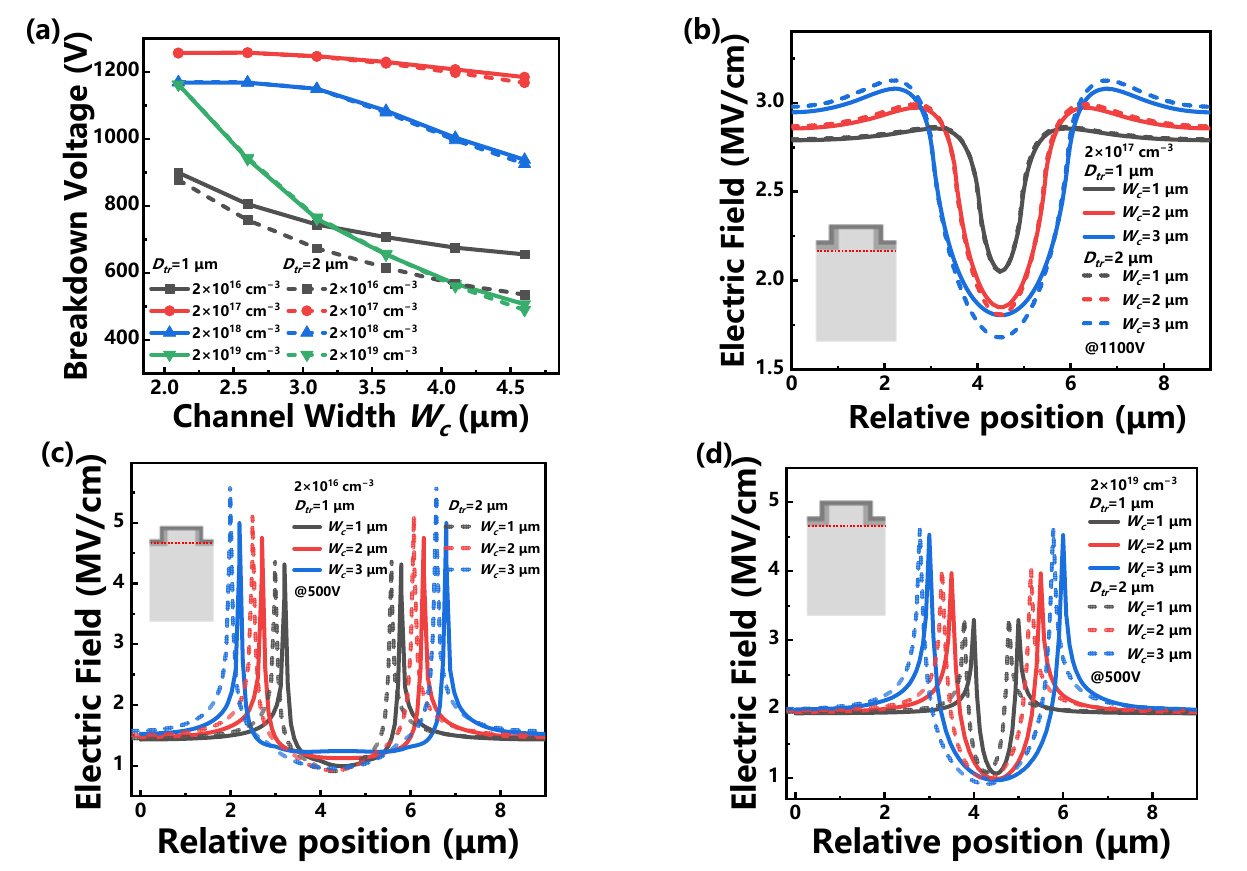
Figure 6. ( a ) Breakdown voltages of TJBS diodes with different p-doping concentrations as a function of adjacent p-GaN spacing and its depth; ( b ) Electric field profiles at the bottom of p-GaN with a doping concentration of 2 × 10 17 cm − 3 and with different D tr and W c of TJBS at a reverse bias voltage of 1100 V; ( c ) Electric field profiles of TJBS diode with p-doping concentration of 2 × 10 16 cm − 3 and different D tr and W c along the interface between metal and p-GaN at 500V; and ( d ) Electric field profiles at the bottom of p-GaN with a p-doping concentration of 2 × 10 19 cm − 3 at a reverse bias voltage of 500 V. To obtain a more obvious comparison the curves for D tr = 2 μ m in ( c , d ) are simultaneously shifted to the left by 0.2 μ m.